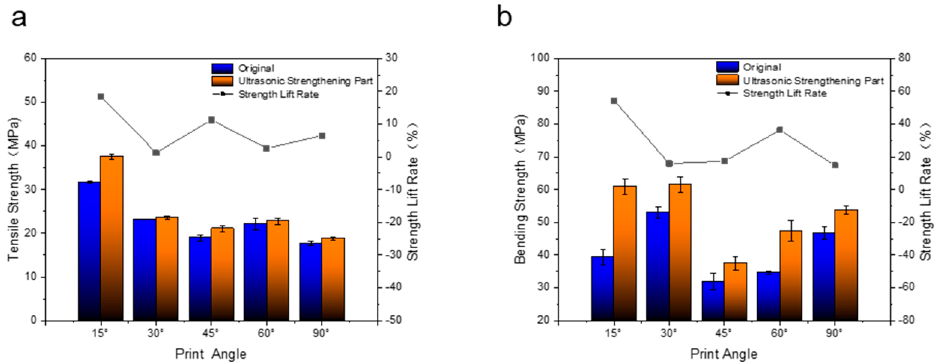
Figure 13. ( a ) Tensile strength of samples with different printing angles before and after ultrasonic strengthening. ( b ) Bending strength of samples with different printing angles before and after ultrasonic strengthening.